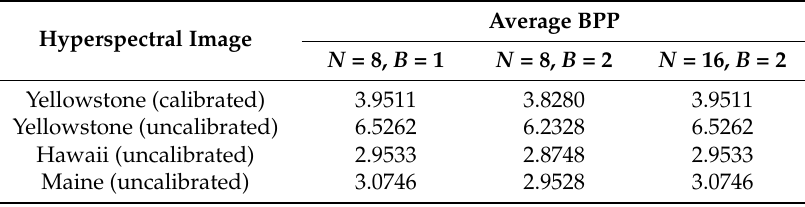
Table 8. Achieved results in terms of BPP (Dataset